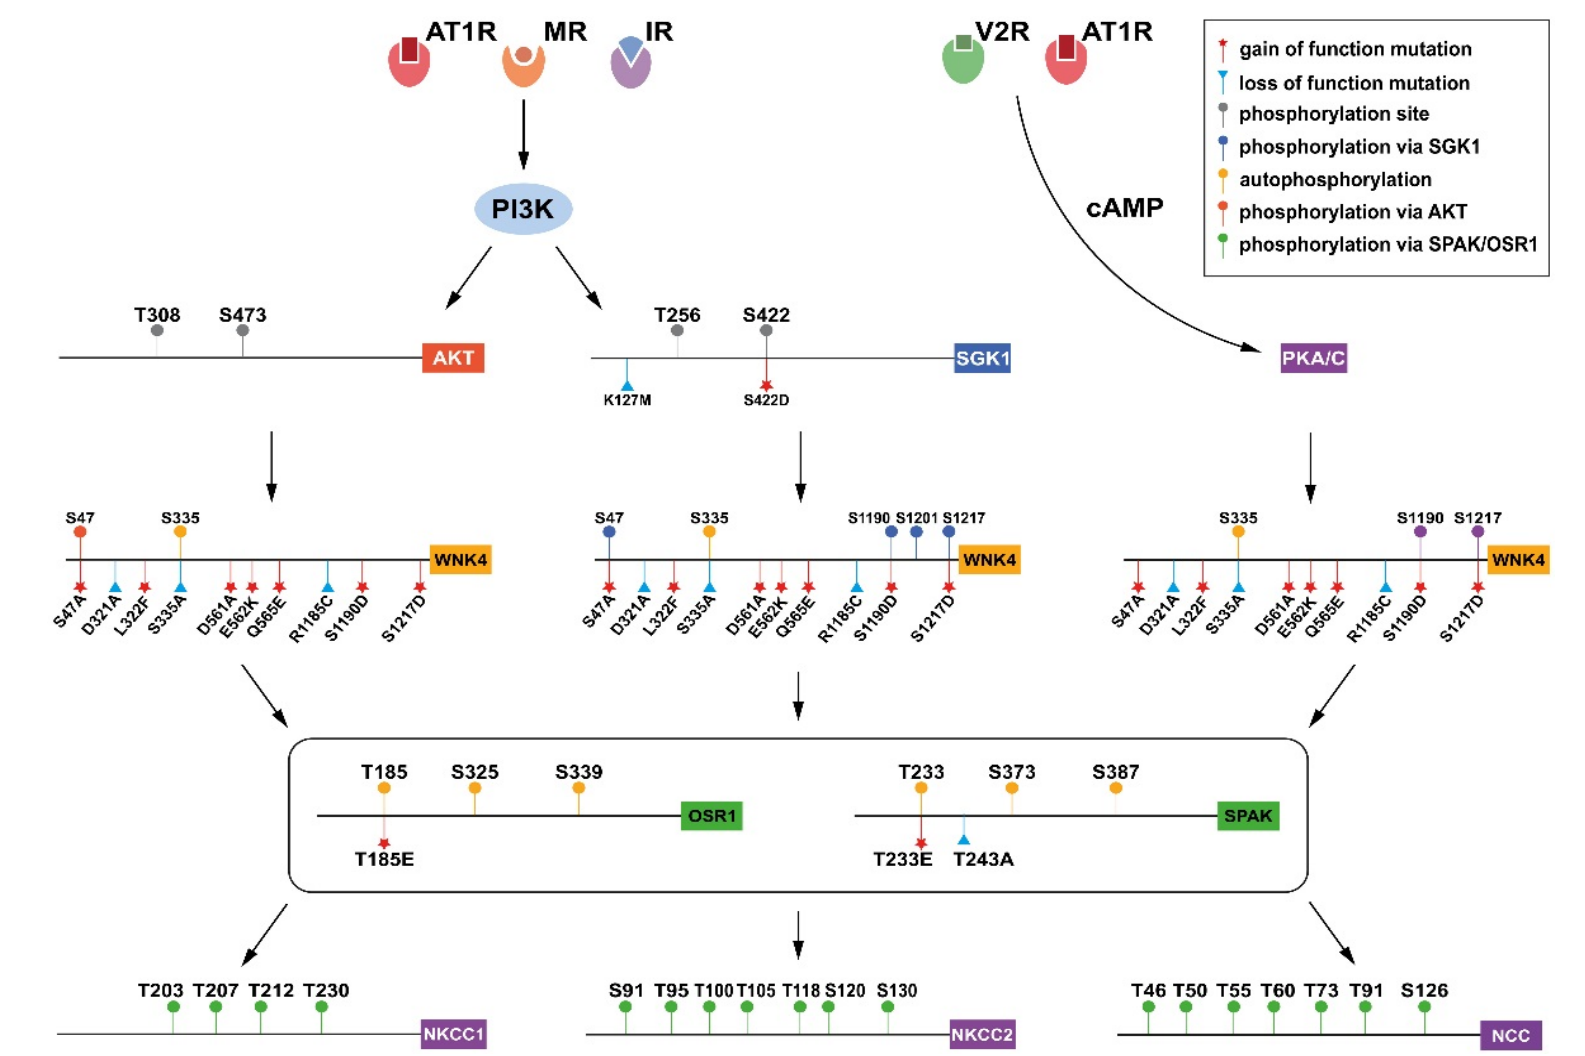
Figure 1. WNK-centric PTM network regulation in renal channels.